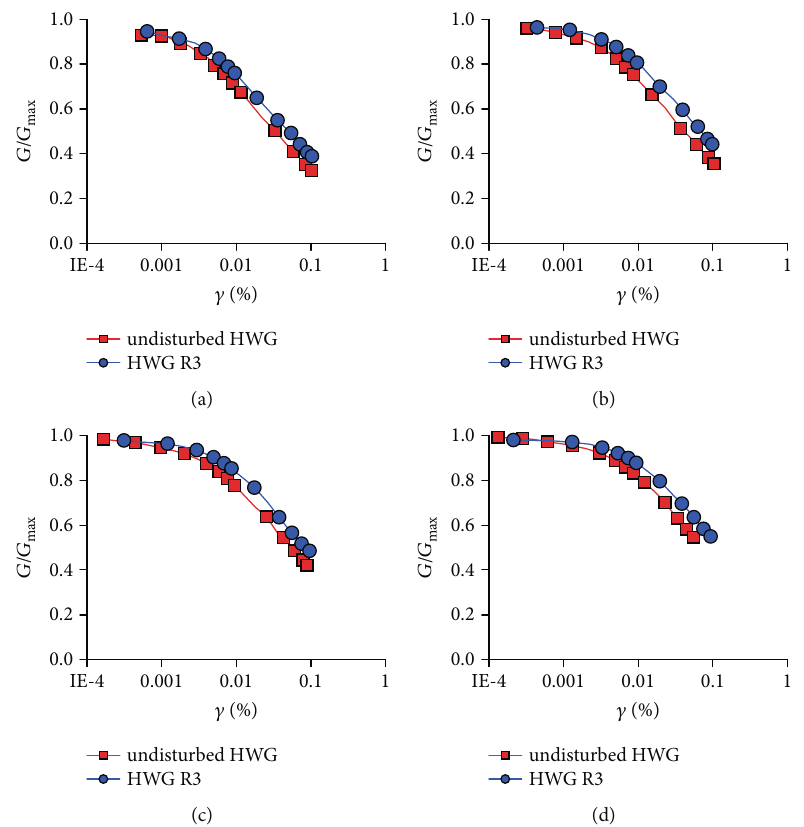
Þ − γ attenuation curves for the undisturbed HWG sample and the remolded HWG R3 sample at Figure 11: Normalized sti ff ness ð G / G max varying consolidation stresses: (a) 100 kPa; (b) 200 kPa; (c) 400kPa; and (d)